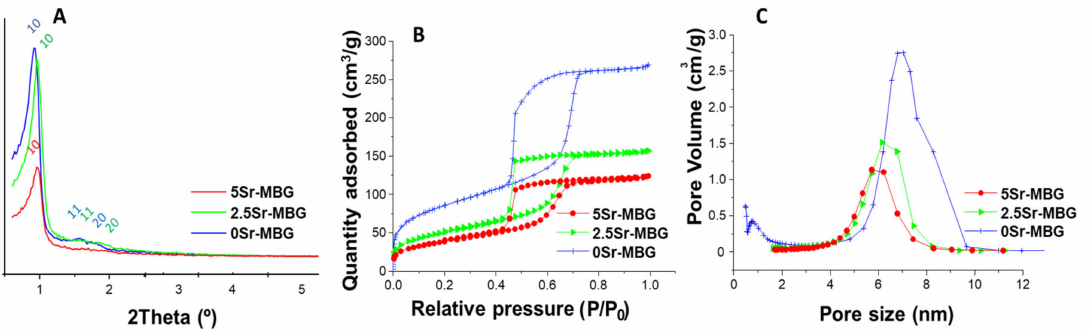
Figure 2. MBG powders characterization: ( A ) small-angle X-ray di ff raction (SA-XRD) patterns. ( B ) Nitrogen adsorption–desorption isotherms and ( C ) pore size distributions of 0, 2.5 and